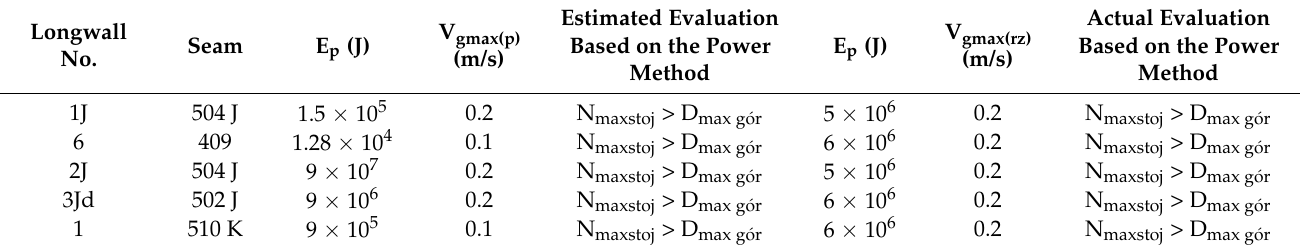
Table 1. Calculation results for the real conditions